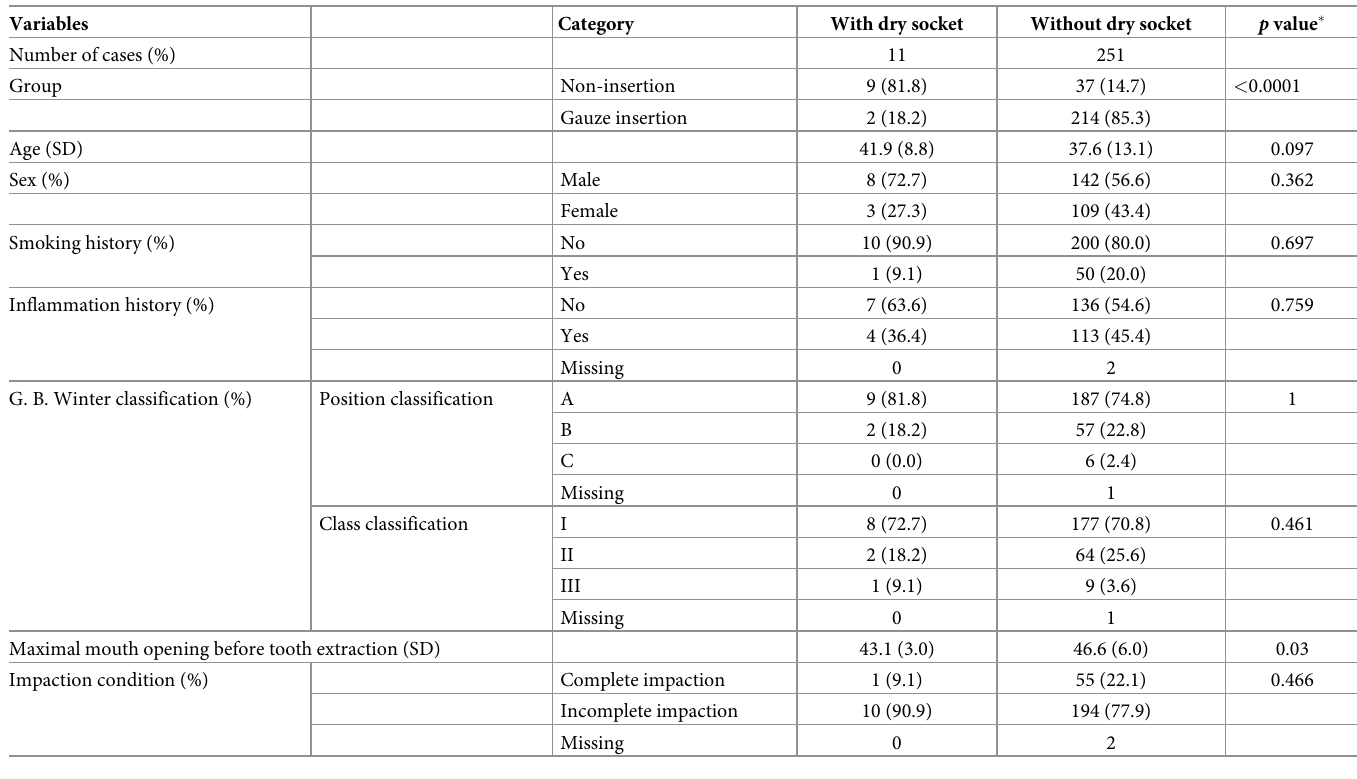
Table 2. Baseline characteristics with/without occurrence of dry